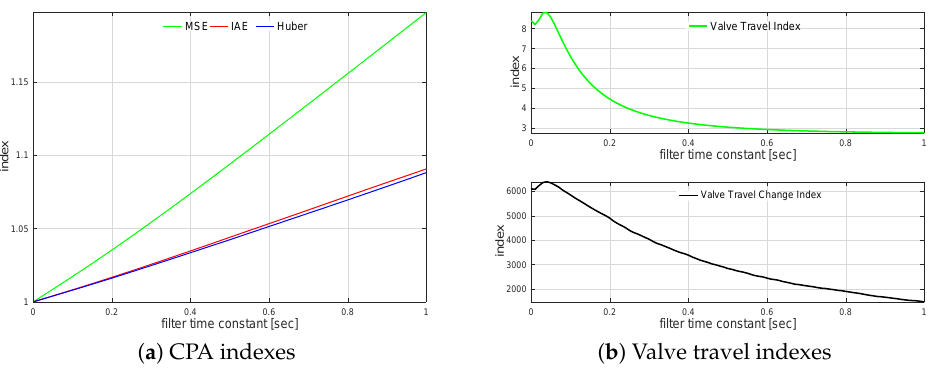
Figure 6. Process variable filtering relationships for G 4 ( s ) . MSE features much faster degradation, compared to the other two indexes. Respec- tive curves are close to the linear. In contrast, even filtering with a small time constant significantly improves the actuator performance, once, for larger time constants, the effect starts to flatten. The curve character is exponential. Thus adding of a small time constant should give much larger improvements in the valve operational wear, without serious loop performance degradation. This observation confirms the common practice that the filtering with a small time constant is always good for a loop. Finally, the effect of the measurement filter on the actuator performance is evaluated. Table 11 shows a comparison of the four filter T F values, i.e., no filter and values of MSE, IAE and σ H when they degrade by 2.0%. We see that robust estimator allows the largest time constants, as it does not focus on squared errors (similar to IAE). Slight 2.0% degradation in the loop performance gives tremendous improvement in valve travel (70 ∼ 80%) and a significant one in valve strokes (25 ∼ 30%). Table 11. Control error filter impact on G 1 ( s ) .